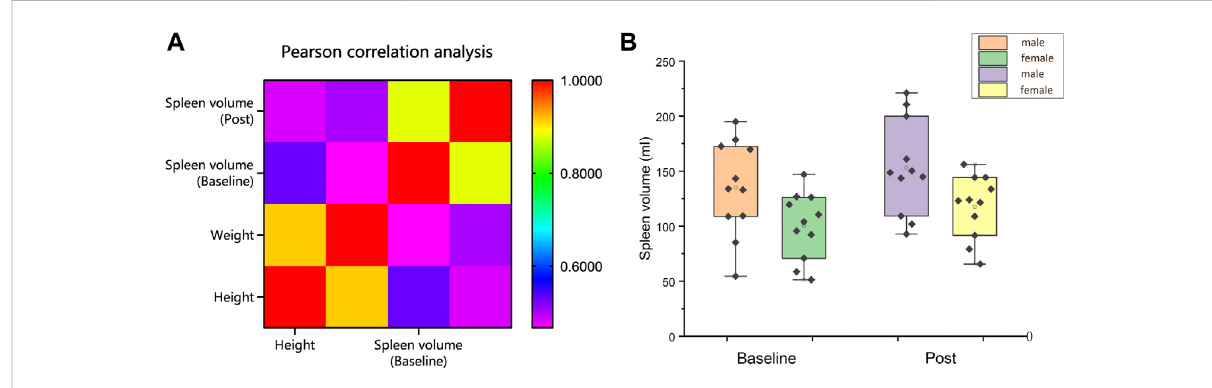
FIGURE 4 (A) Correlation analysis of height and weight with spleen size; (B) Spleen volume (ml) comparison between male and female before and after training (Mean ± SE).